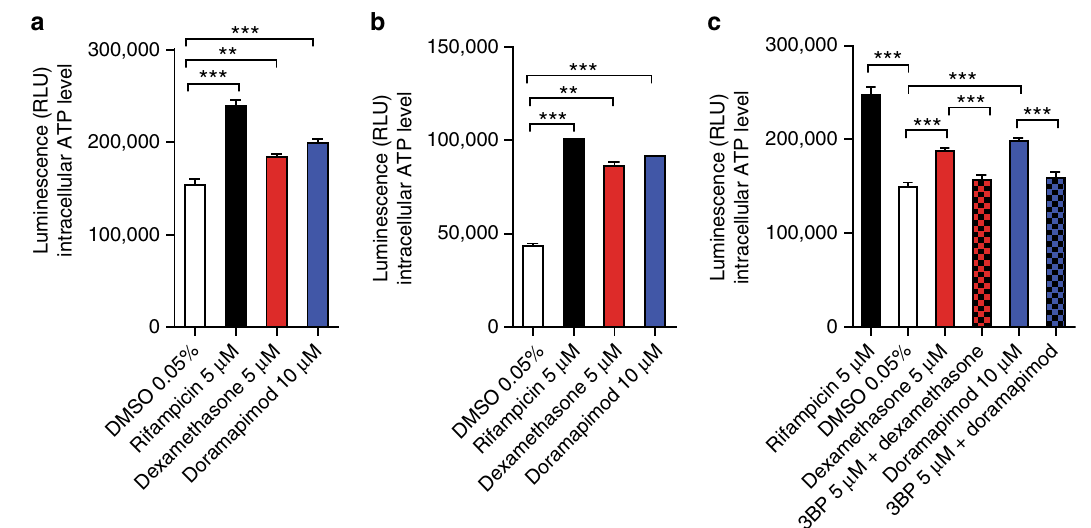
Fig. 6 p38 MAPK inhibition preserves intracellular ATP levels. a, b Intracellular ATP levels in Mtb -infected J774.2 M φ ( a ) and MRC-5 lung fi broblasts ( b ) following 24 and 48 h of infection, respectively. Cells were treated with dexamethasone (5 µ M) or doramapimod (10 µ M). c Intracellular ATP levels in Mtb - infected J774.2 M φ treated with dexamethasone (5 µ M) and bromopyruvic acid (3BP) (5 µ M) or doramapimod (10 µ M) and bromopyruvic acid (5 µ M) after 24 h of infection. Data from two experiments with multiple replicates are shown in a and b and data from one of two experiments are shown in c . Results are expressed as mean ± SEM and experiments were analyzed using unpaired t -test (** p ≤ 0.01; *** p ≤